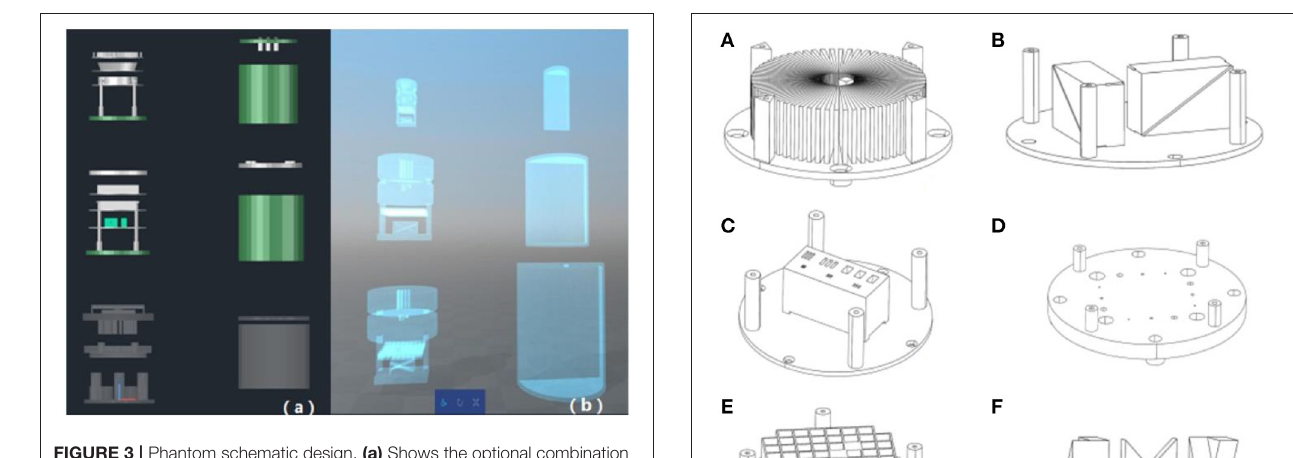
FIGURE 3 | Phantom schematic design. (a) Shows the optional combination of 3D-printed test inserts and conventional PMMA shells; (b) shows the optional combination of entirely printed test inserts and shells.